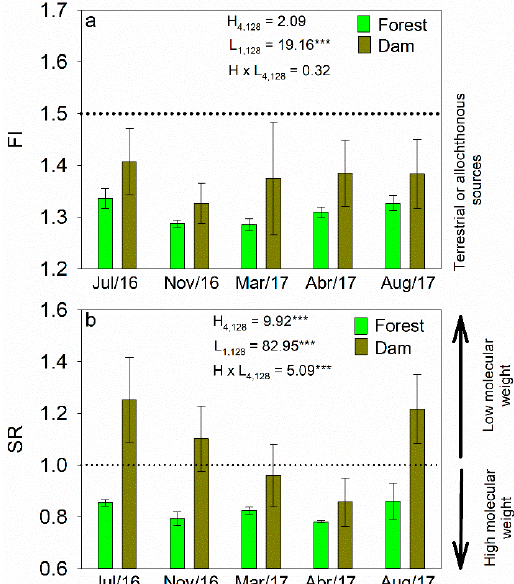
Figure 4. Mean (±95% CI, n = 11 Dam; n = 15 Forest) at the research site, grouped by Dam and Forest catchments and hydrological month for ( a ) fluorescence index (FI) and ( b ) slope ration (SR). The statistical results are expressed using the Tamhane test of non-presumed equal variances and the probability of type I error (P) to test with land cover (L) and hydrological month (H) as fixed effects. *** p < 0.001. Dotted lines indicate threshold values for FI [51] and SR